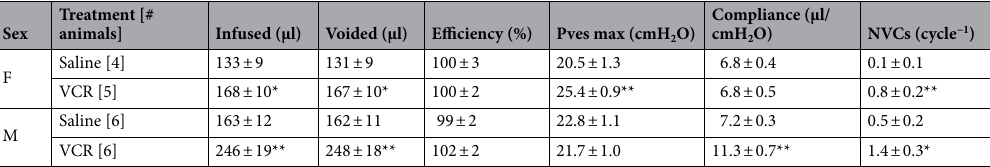
Table 2. Comparison of urodynamic parameters between the groups . Significant increases in functional bladder capacity, voided volume, and the number of non-void contractions were observed in both female and male mice received VCR. VCR exposure induced increases in Pves max and bladder compliance in females and males, respectively, in comparison with the control group. Mean ± SE, *p < 0.05 and **p < 0.005 vs. the control group, Pves max, maximum intravesical pressure at micturition, NVCs, non-void contractions per micturition cycle.